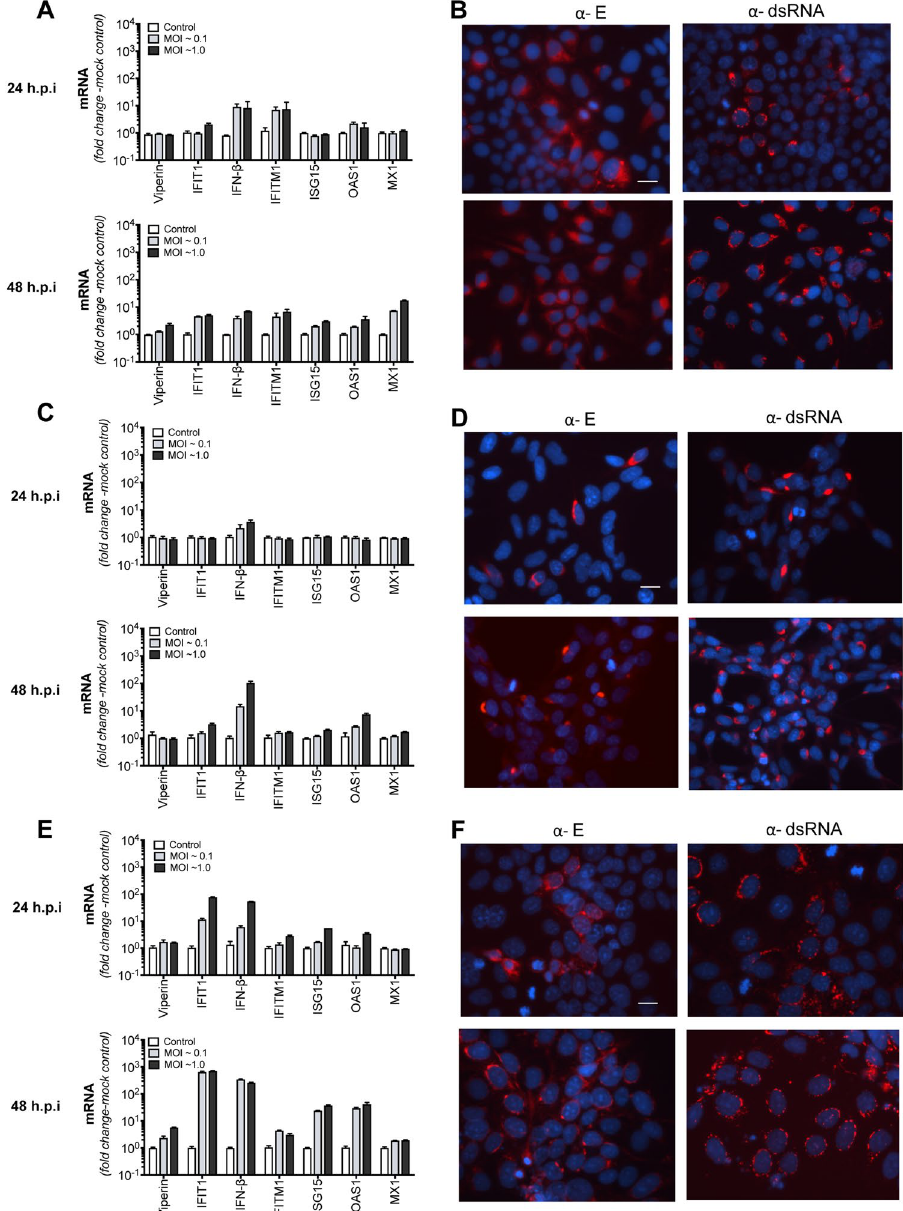
Figure 1. ZIKV infection results in an attenuated interferon-stimulated gene (ISG) response. ( A , C and E ) Huh-7, HTR8/SVNeo and Jeg3 cells, respectively were infected with ZIKV (MR766) at indicated multiplicity of infection (MOI). At 24 and 48 h.p.i total RNA was extracted and qRT-PCR was used to detect mRNA for IFN- β and the ISGs IFIT1, viperin, IFITM1, ISG15, OAS1 and Mx1. Data are normalised to the RPLPO housekeeping gene and expressed as a fold-change relative to mock-infected control (data are means + SD, n = 3). ( B , D and F ) Indirect immunofluorescence of corresponding ZIKV infection in Huh-7, HTR8/SVNeo and Jeg3 cells respectively. Cells were stained with the 4G2 antibody to detect ZIKV E antigen or 3G1 antibody to detect dsRNA (red) and DAPI DNA stain (blue). Scale bars represent 20 μ